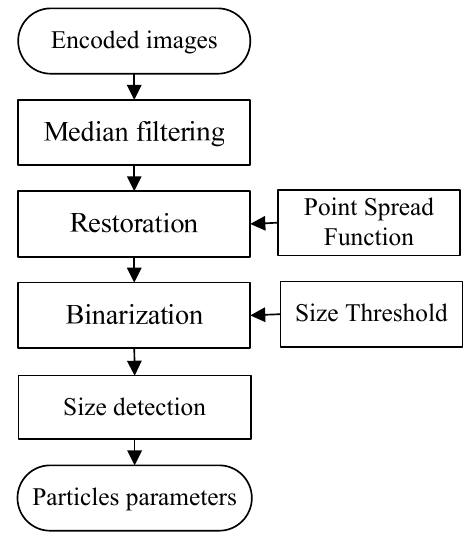
Figure 5. Flowchart of image processing and feature extraction.